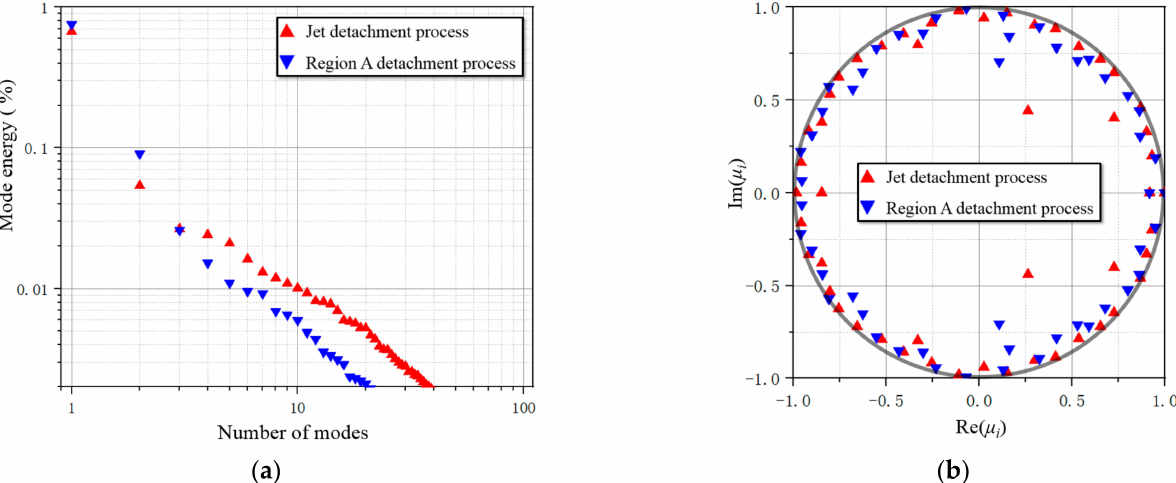
Figure 13. DMD results of the PIV velocity nephogram under jet transient detachment process conditions. ( a ) The modal energy distribution of DMD under the conditions of the jet detachment process; ( b ) the distribution of the real and imaginary parts of the eigenvalues on the unit circle under the conditions of the jet detachment